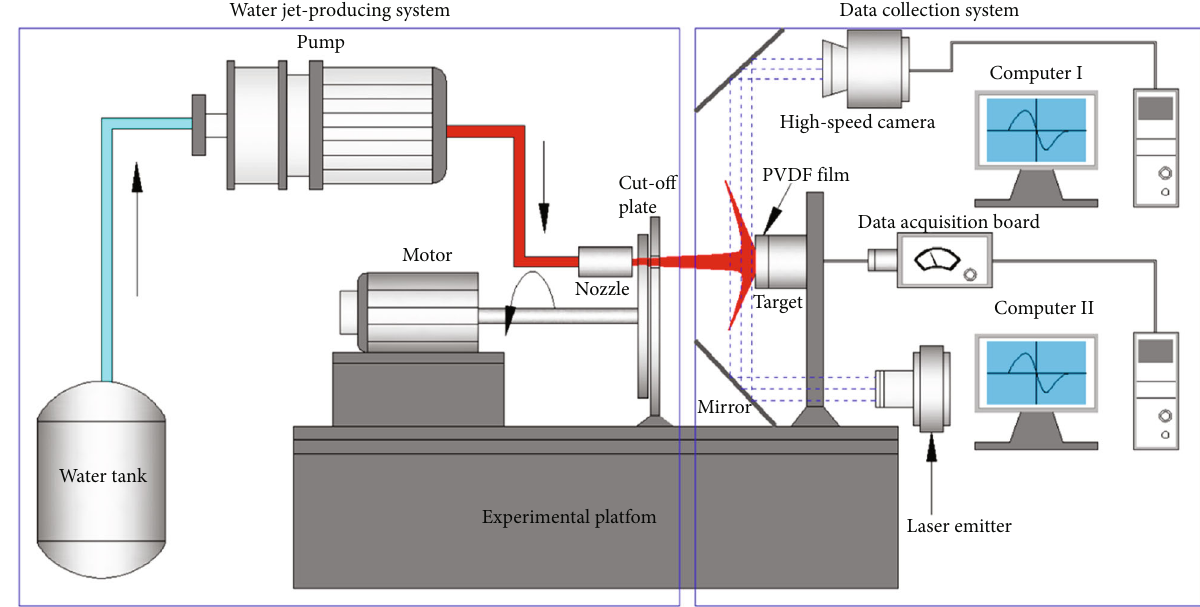
Figure 3: Schematics of the experimental setup used in the present